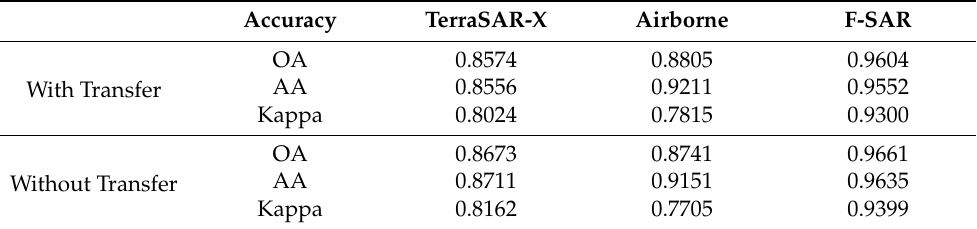
Table 10. Comparison of the performance with or without transfer model from the Gaofen-3